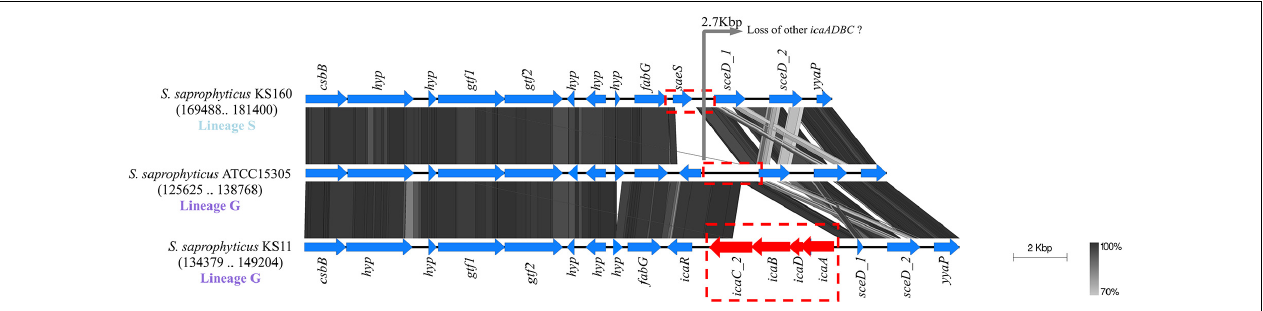
FIGURE 4 | Evidence for probable loss of ica gene cluster in Staphylococcus saprophyticus . Blocks of identical color represent nucleotide sequence homology between regions found in the two species. The darker-shade region depicts the highest homology, and genes are represented by arrows facing the direction of transcription. The icaR gene was ubiquitous in lineage G; and within this lineage, additional ica genes that were found in some of the isolates were located downstream. saeS gene was located in place of icaR in lineage S. Comparison figure was generated using EasyFig.